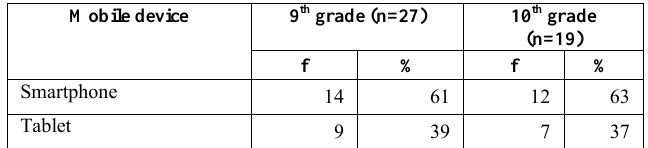
Table 5. Mobile device used to play games outside